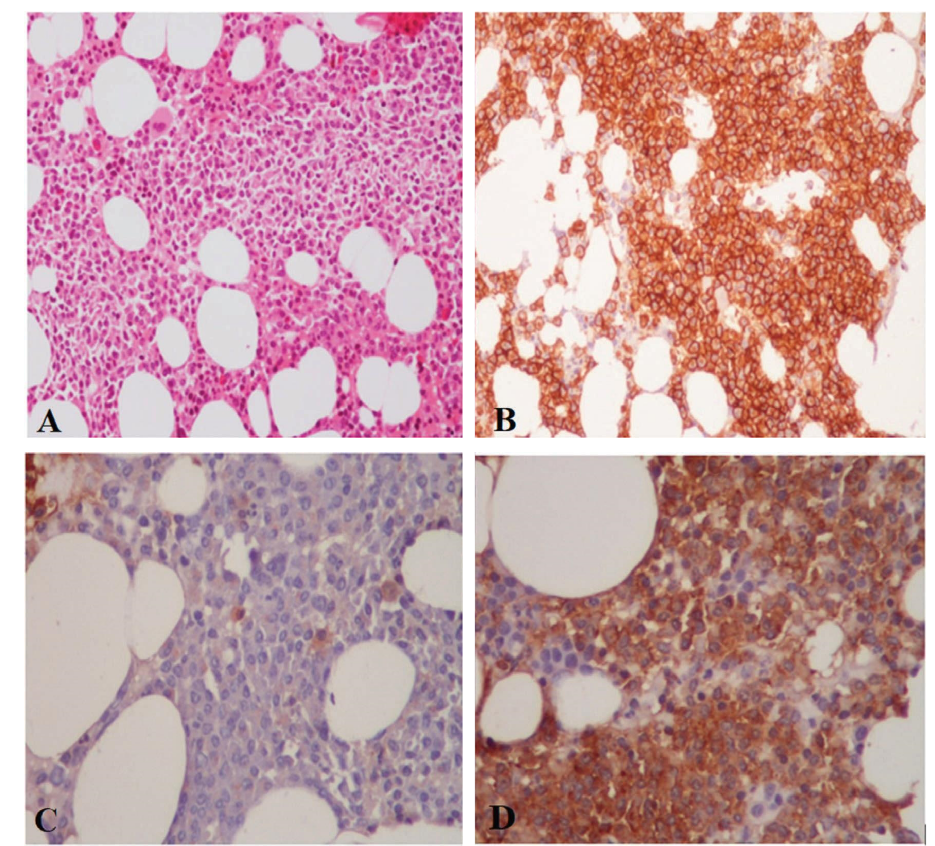
Figure 4: Bone marrow shows sheets of plasmacytoid cells. (a) H&E. (b) CD138. (c) Lambda. (d)